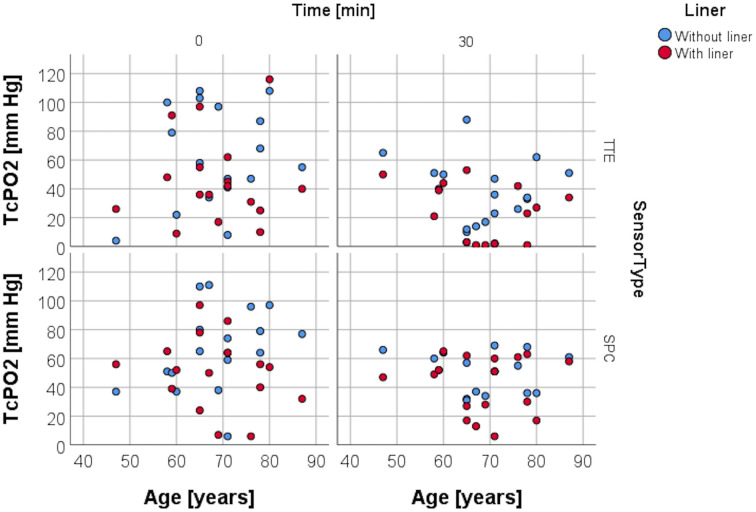
TcPO2 levels and age.Scattergram depicting distribution of TcPO2 levels with and without liner wear depending on the age of the participants.